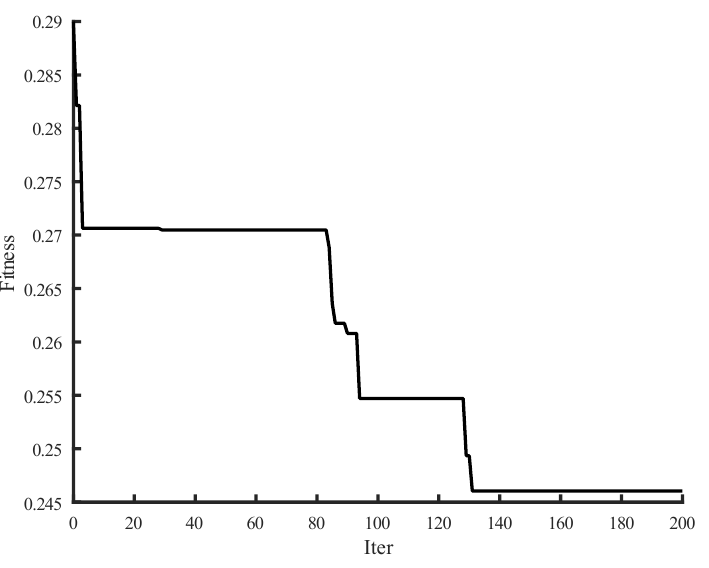
Table 2. Results of ADF.